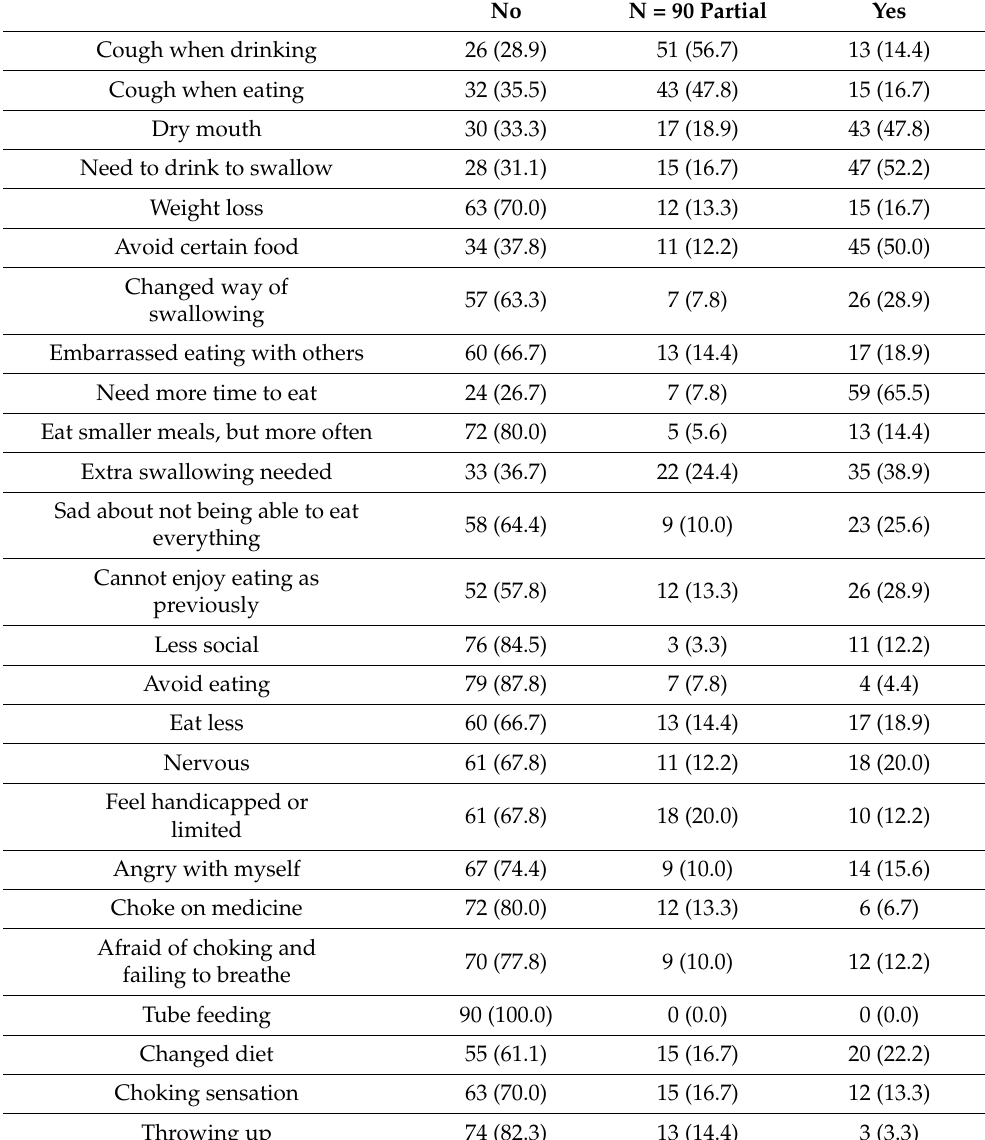
Table 3. Results for DHI-DK.